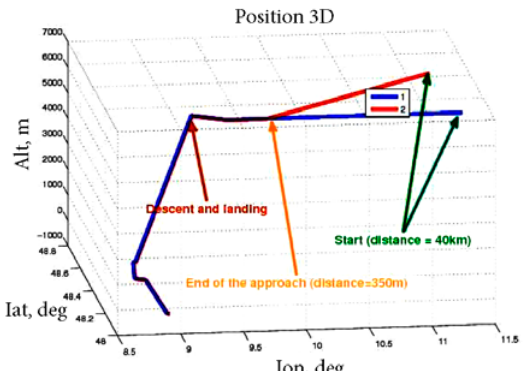
Fig. 5. Presentation of the simulated trajectory; the rover gets closer to the master (up to 350 m) and then flies alongside.